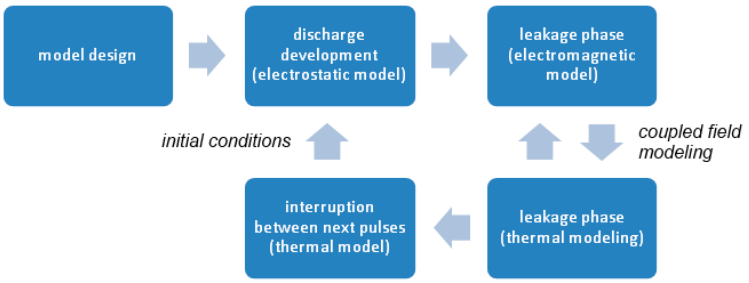
Figure 6. Schematic diagram of the calculation algorithm.